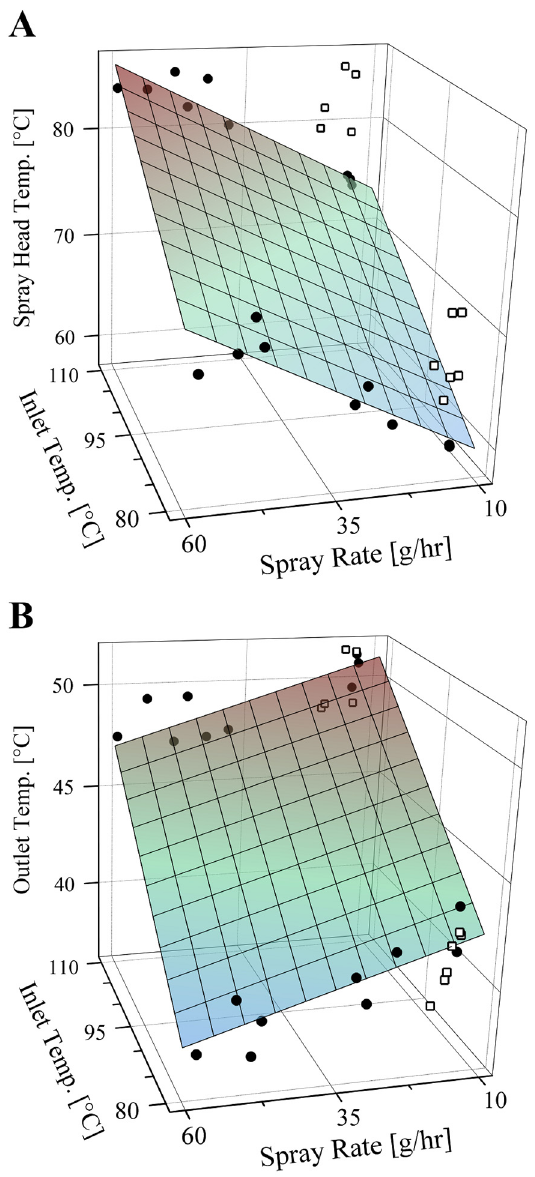
Figure 4. The dependence of the spray head temperature (panel ( A )) and the outlet temperature (panel ( B )) in the Nano Spray Dryer B-90 on the inlet temperature and the spray rate. The surface plots were simulated using multiple linear relationships derived from data of spray drying of aqueous lactose solutions. Filled circles represent actual data of aqueous lactose solutions. Open squares represent actual data of hydroethanolic lactose solutions for comparison.